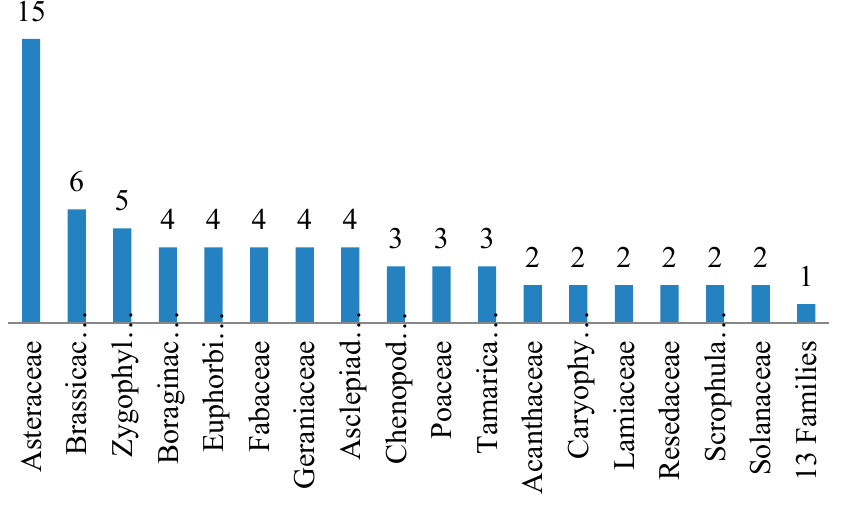
Figure 3. Number of species distributed across different families recorded in Wadi Hagul.